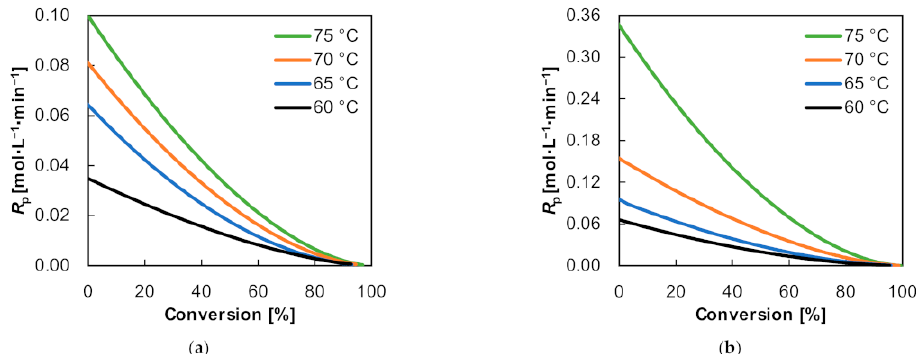
Figure 8. Polymerisation rate of acrylic acid polymerisations in isopropyl alcohol (150 g/L) at different temperatures as a function of conversion determined by Raman spectroscopy: 0.5 mol% AIBN ( a ), and 1.0 mol% AIBN ( b